Question: What style of plot is this figure drawn as?
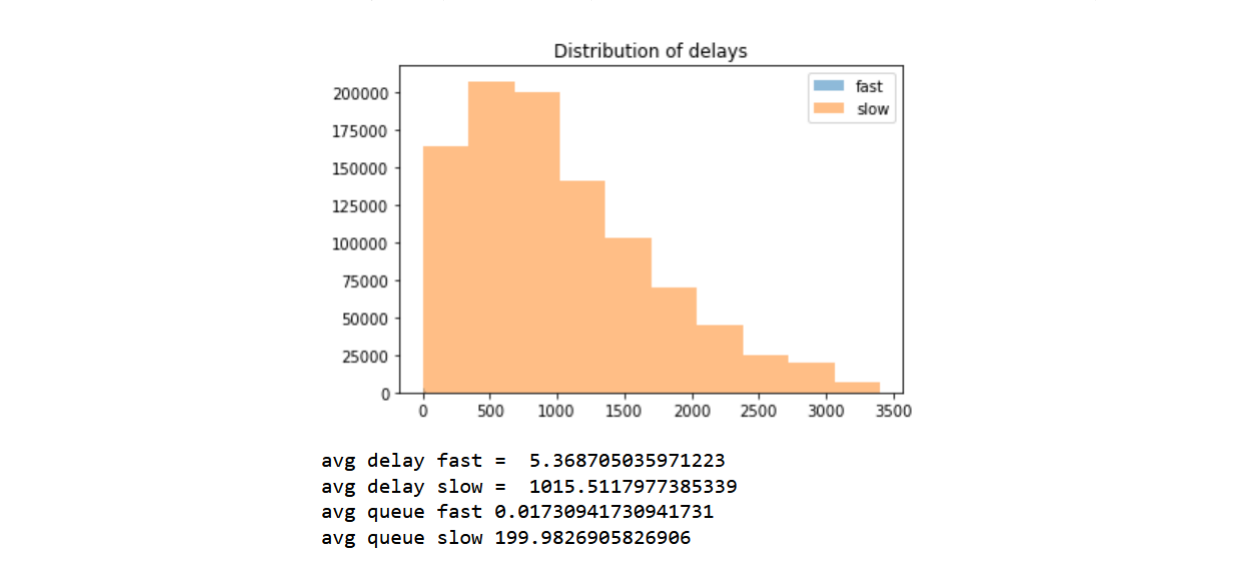
Answer: histogram